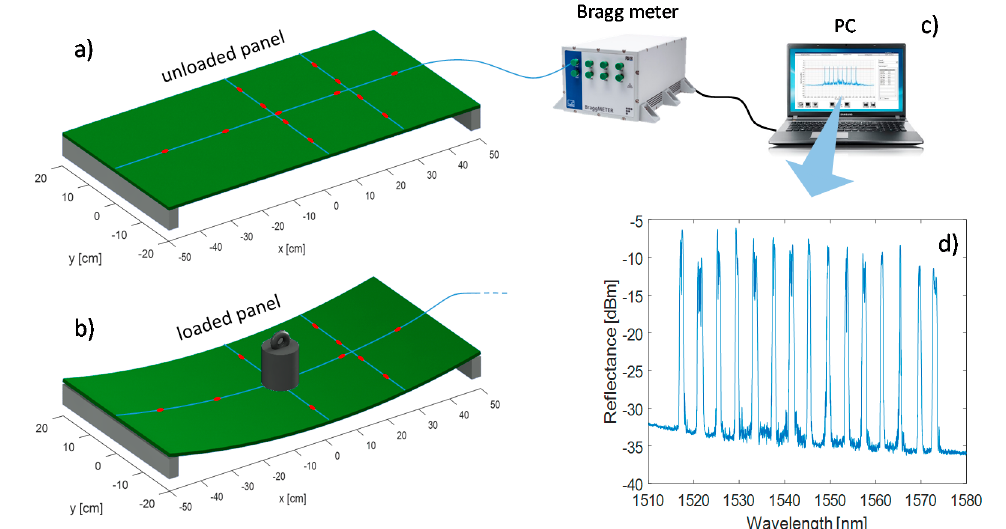
Figure 2. Schematic ( a ) unloaded panel; ( b ) loaded panel; ( c ) interrogation setup; ( d ) reflectance spectrum of the FBGs embedded in the panel .